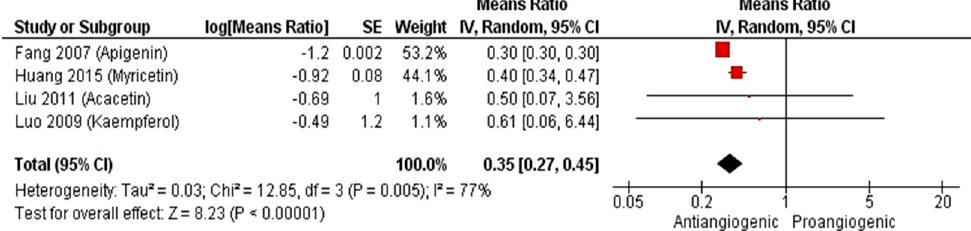
Figure 9. Forest plot of means ratio and 95% confidence interval (CI) of number of blood vessels relative to control of flavonoids on OVCAR-3 cell lines.